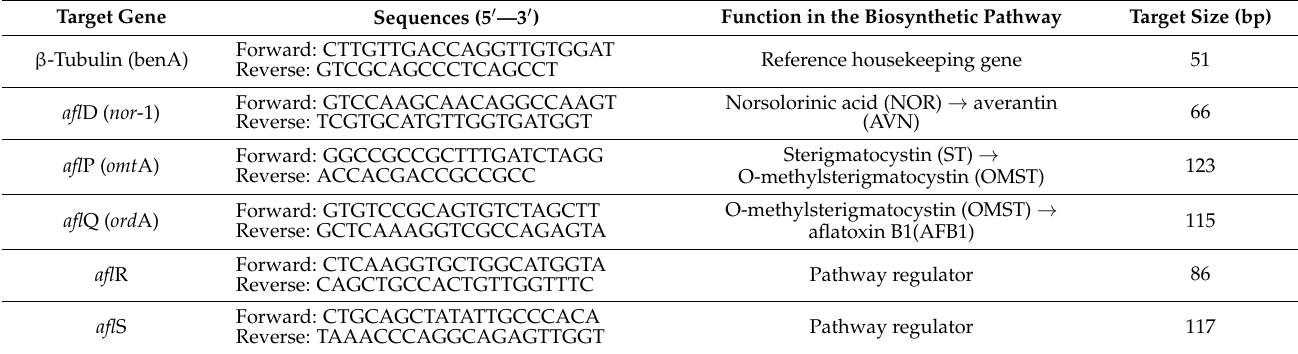
Table 2. The list of primers and the corresponding clustered aflatoxin biosynthesis pathway genes showing enzymes involved and their functions in the study. Target